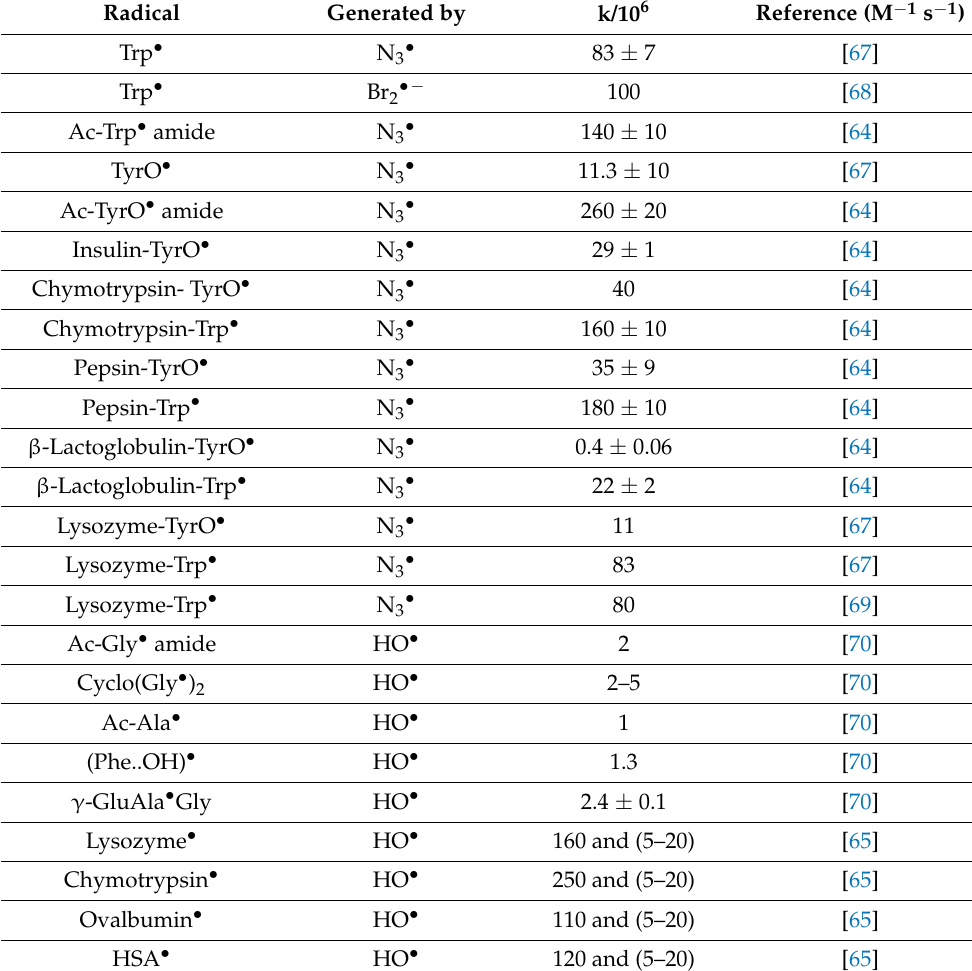
Table 2. Rate constants of reactions of ascorbate with amino acid, peptide, and protein radicals. Radical Generated by k/10